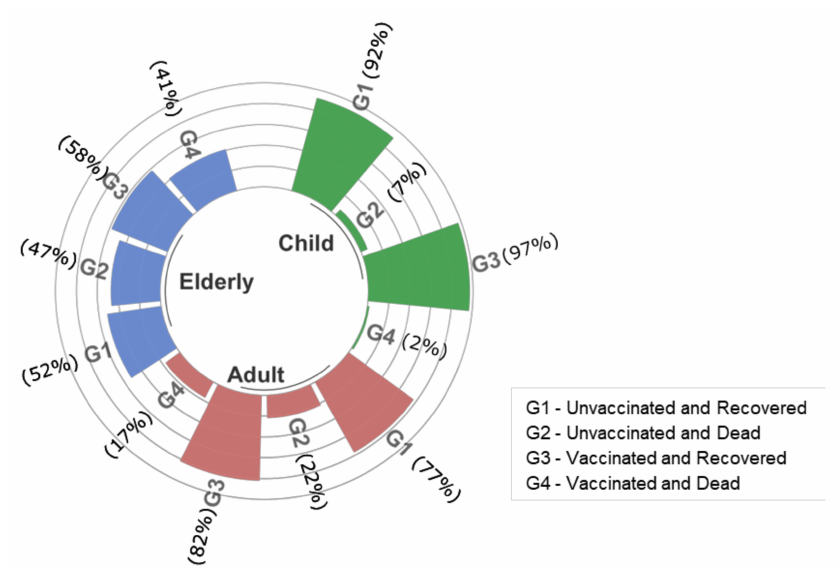
Figure 3. In-hospital mortality and recovery for October to December 2021 with the predominance of Delta. “G1” stands for unvaccinated and recovered patients, “G2” for unvaccinated and dead, “G3” for vaccinated and recovered, and “G4” for vaccinated and dead. Age was stratified into three